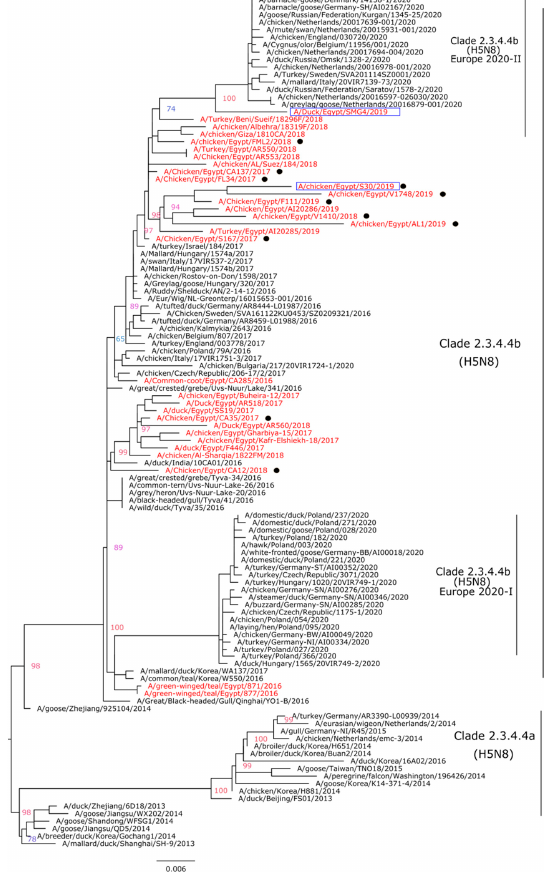
Figure 2. Phylogenetic tree of the HA gene segment of HPAI H5N8 viruses. A phylogenetic tree including a total of 114 HA segments from different H5N8 viruses was obtained using the IQTree software after selection of best fit model (K3Pu + F + G4). Egyptian HPAI H5N8 viruses are colored in red; viruses of the current study ( n = 11) are indicated with black dots. The two Egyptian HPAI H5N8 viruses selected for IVPI are shown in blue boxes.